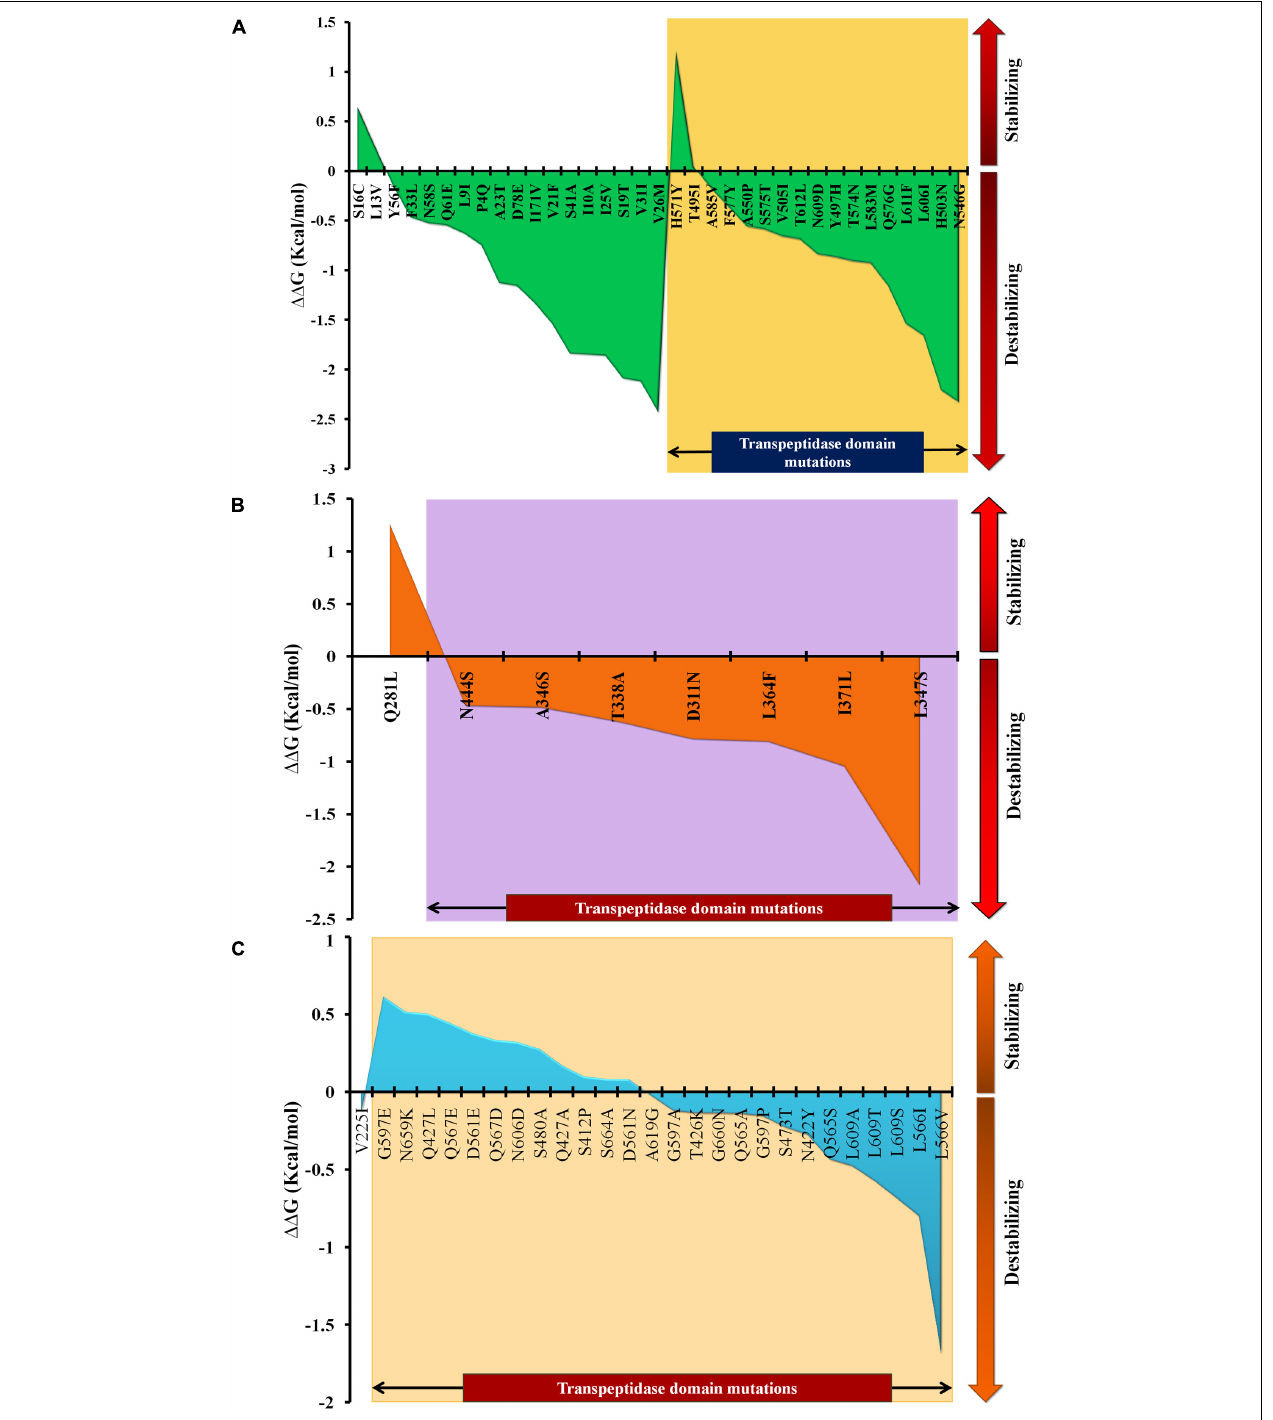
FIGURE 1 | The (cid:49)(cid:49) G patterns as a result of stabilizing and destabilizing mutations, especially in the transpeptidase domains of (A) PBP1A, (B) PBP2X, and (C) PBP2B.